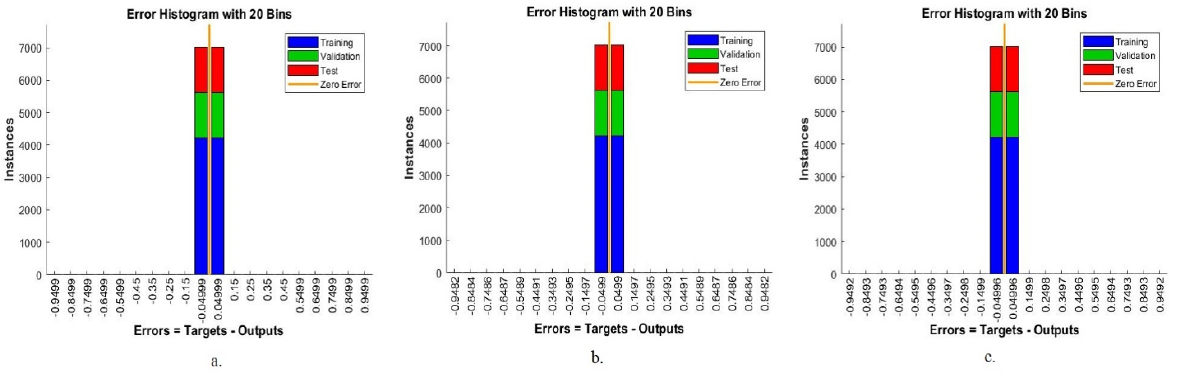
Figure 16. Error histogram of ANN on hemorrhage dataset based on hybrid features by ( a ) GoogLeNet and GLCM + LBP, ( b ) ResNet-50 and GLCM + LBP and ( c ) AlexNet and GLCM +